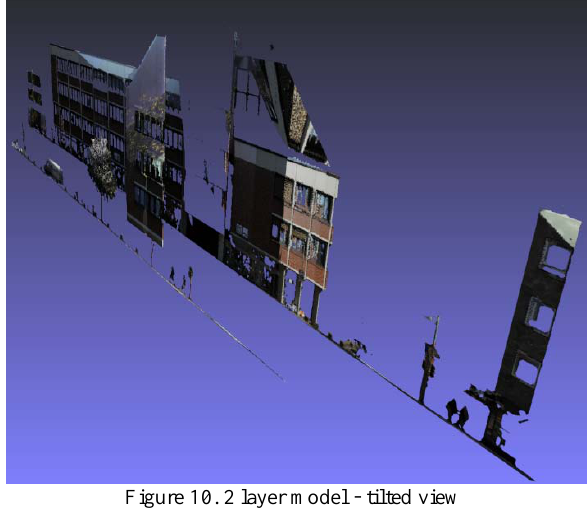
Figure 10. 2 layer model - tilted view